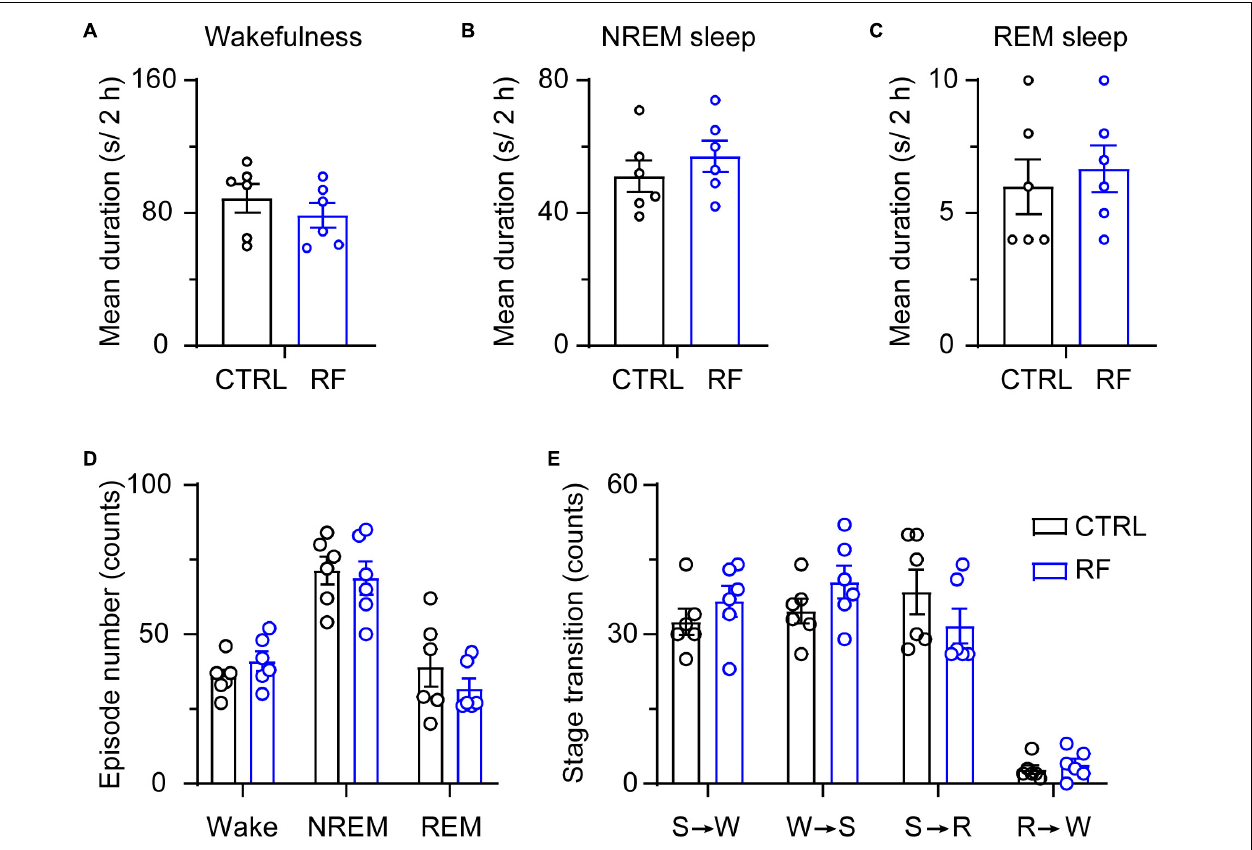
FIGURE 5 | Sleep-wake architecture in the RF and CTRL groups at baseline. The mean durations of wakefulness (A) , NREM sleep (B) , and REM sleep episodes (C) and number of sleep-wake and sleep-wake transition episodes during the 2 h proceeding the dark period (D) . Transitions between stages during the 2 h proceeding the dark period (E) . CTRL, control; RF, restricted feeding; R, REM sleep; S, slow-wave sleep; W,